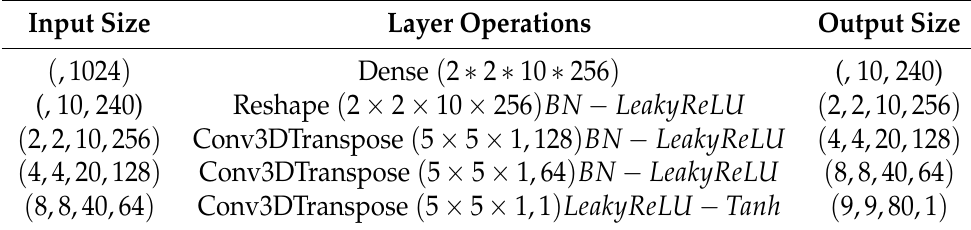
Table 4. The implementation details of spatial Generator G 2